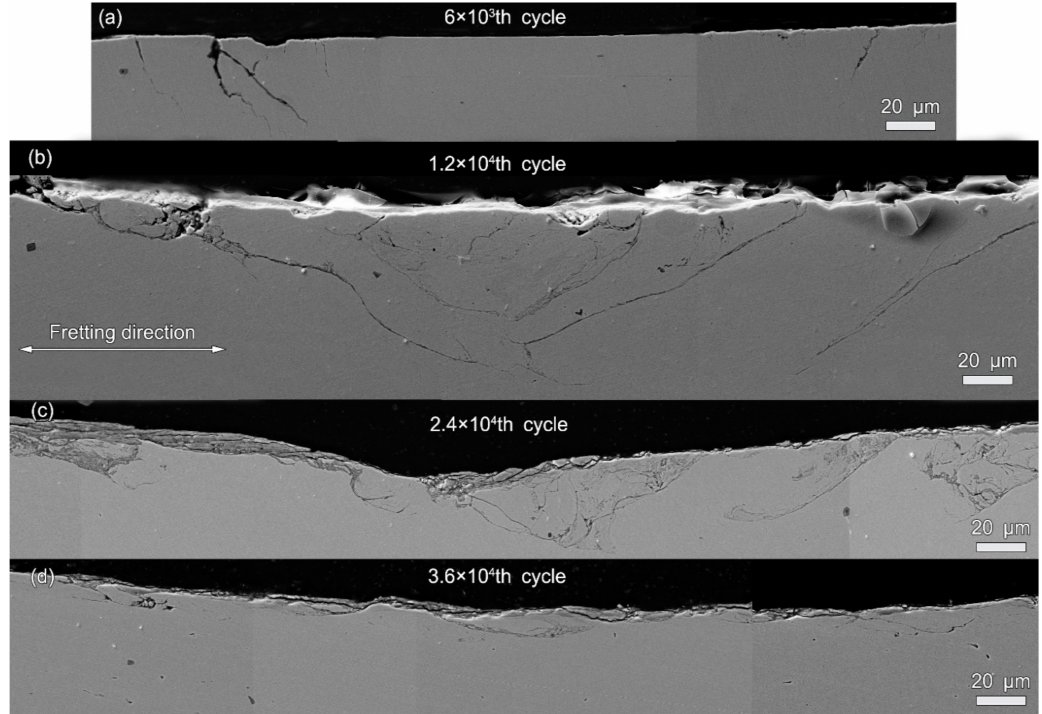
Figure 7. The SEM images of cross-sections of alloy 690TT after fretting cycles of ( a ) 1.2 × 10 3 , ( b ) 6 × 10 3 , ( c ) 1.2 × 10 4 , and ( d ) 2.4 × 10 4